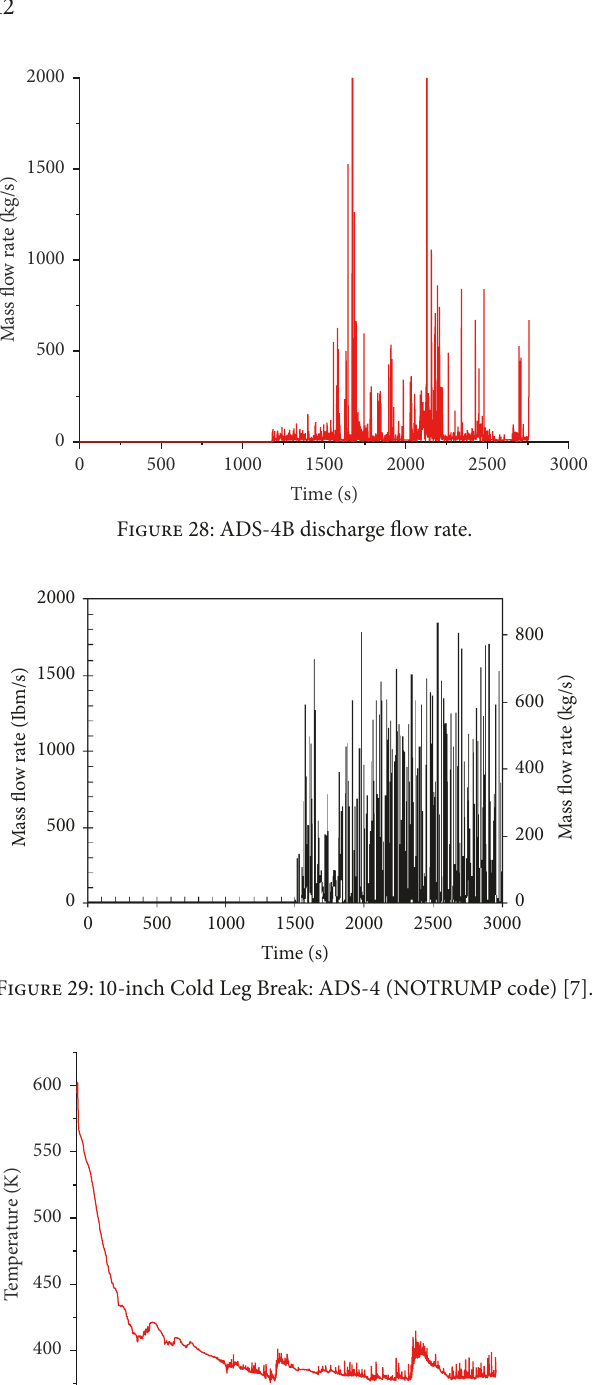
size. The results and accident sequence are compared with that of NOTRUMP code as obtained by